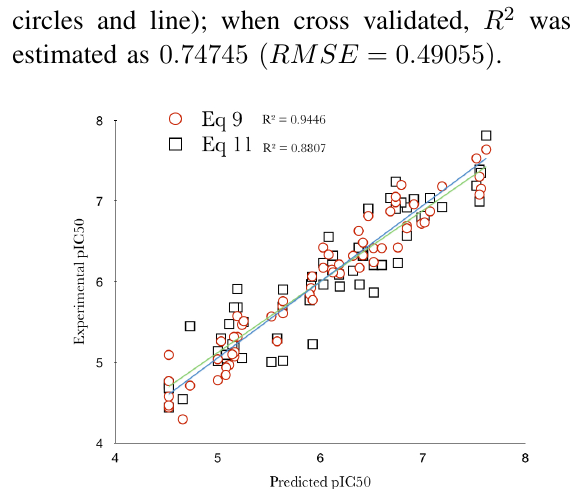
Fig. 1: Scatter plot of the experimental pIC 50 vs. pIC 50 -predictions of Eq. (10) (blue) and Eq. (12) (green).